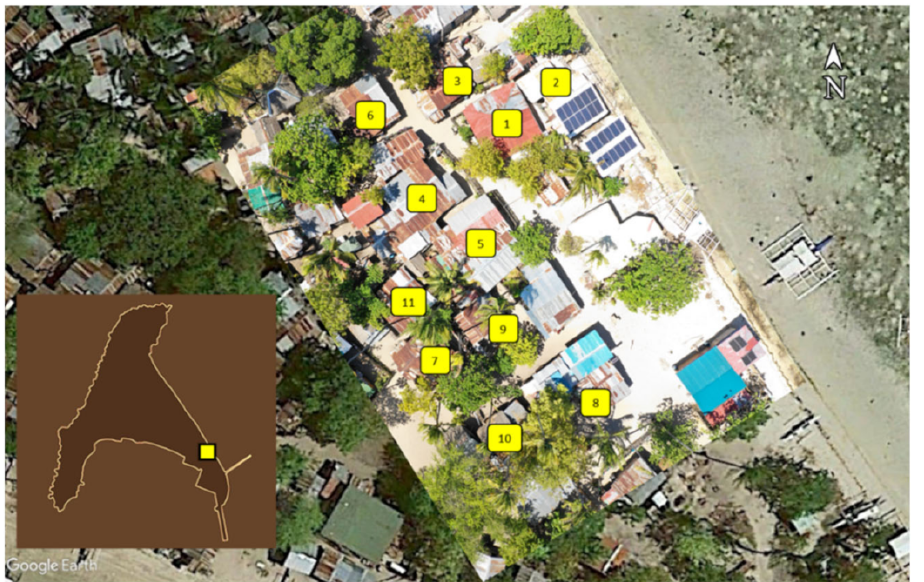
Figure 11. The household cluster of the rooftop solar microgrid showing the connected houses labelled from 1 to 11. The main image is a drone photo superimposed on Google Earth satellite imagery. The inset image shows the outline of Gilutongan Island with the yellow box indicating the solar microgrid’s